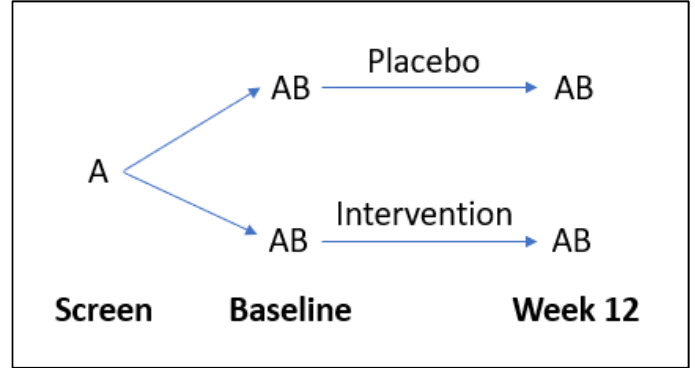
Figure 2. Flow diagram of study design. A = questionnaires, B = laboratory tests.